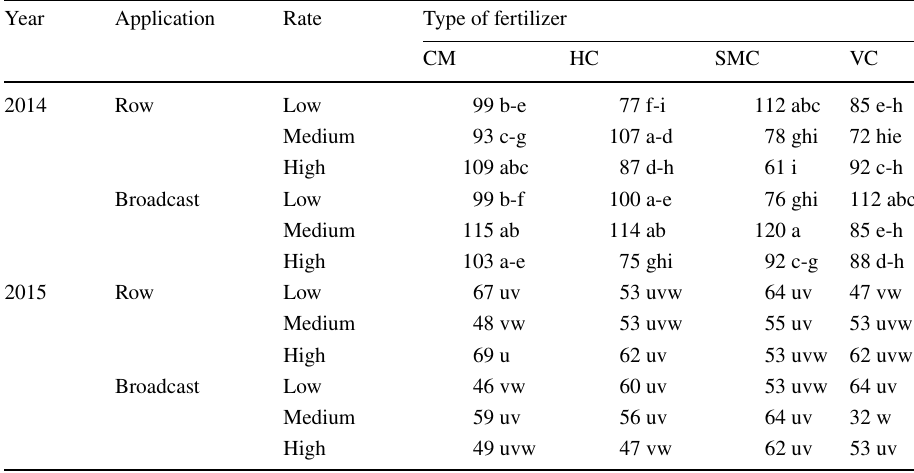
Table 5 Effects of different soil amendments with different rate and application method on yield (t ha −1 )